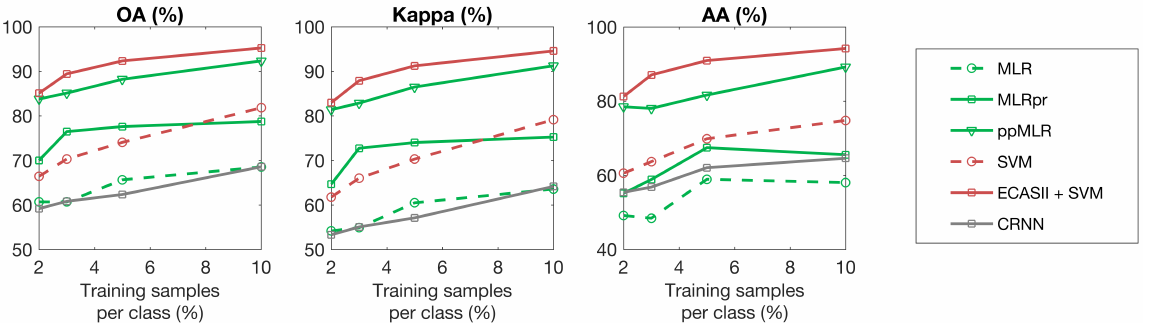
Figure 16. Classification accuracies (%) for different algorithms applied to the Indiana scene using different numbers of training samples.